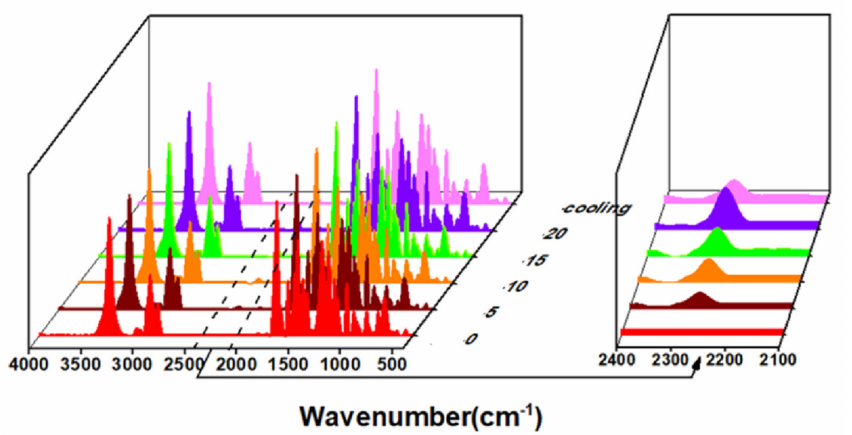
Figure 9. The IR spectra of P(Eug-HDI) vs. different heating time. Similarly, the P(Syol-HDI) and P(Syol-MDI) were heated at 150 ◦ C and 140 ◦ C for 20 min, respectively. The infrared spectra of 0 min (before heating), 5 min, 10 min, 15 min, 20 min and 10 min after cooling were measured, respectively. The results are shown in Figures 10 and 11. It can be qualitatively seen that in the heating process, the stretching vibration peak of N-H on the amino ester bond at 3320 cm − 1 was widened and moved to the high field to the stretching vibration peak of the hydroxyl (OH) at 3350 cm − 1 , indicating that part of the amino ester bond in the polymer was thermally decomposed and hydroxyl was regenerated. The characteristic absorption peak of the isocyanate appeared near 2300 cm − 1 , and the peak intensity increased with the increased heating time, but the characteristic absorption peak of the NCO did not change after cooling for 10 min. The above results indicate that the alcohol hydroxyl polyurethanes P(Syol-HDI) and P(Syol-MDI) had only thermal decomposition behaviors, they could not cause a re-urethane reaction and that this was